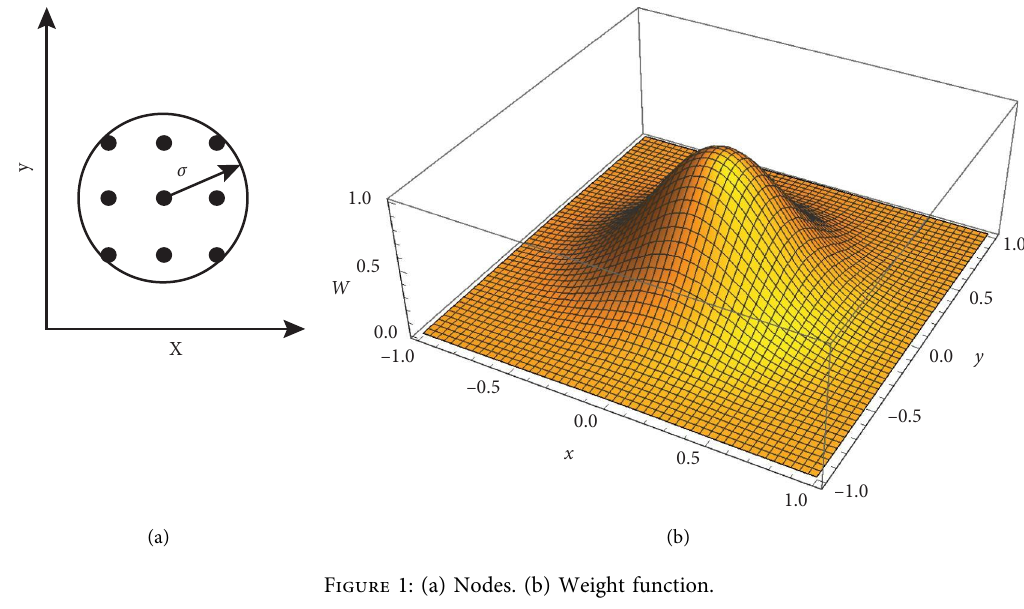
Figure 1: (a) Nodes. (b) Weight